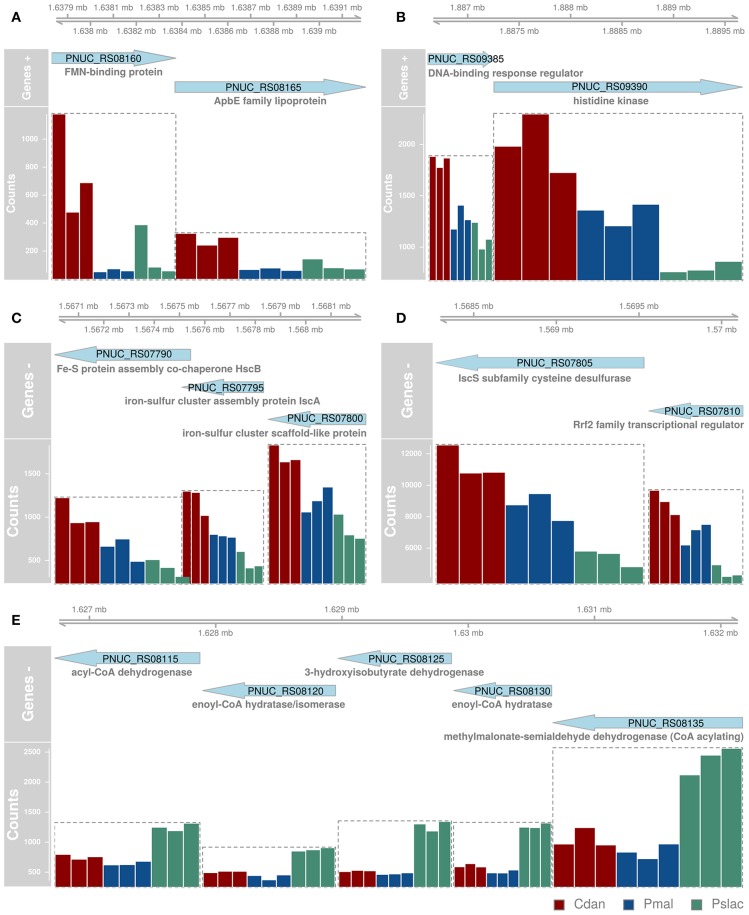
Most significant differentially expressed genes between single-species conditions which are structured in operons. Since many bacterial genes are organized in operons and expressed together, genes which likely belong to the same operon (A-E) are depicted here with their position in the genome (top), orientation (genes +, genes -) and normalized gene counts as bars colored by sample type. Since we did not want to overestimate gene functions of differential genes with similar functions belonging to the same operon, we had to determine the operons prior to functional analyses. All significant differentially expressed genes can be found in Figure S2 and the 20 most differentially expressed genes (independent of operon structure) are also depicted in Figure 4.